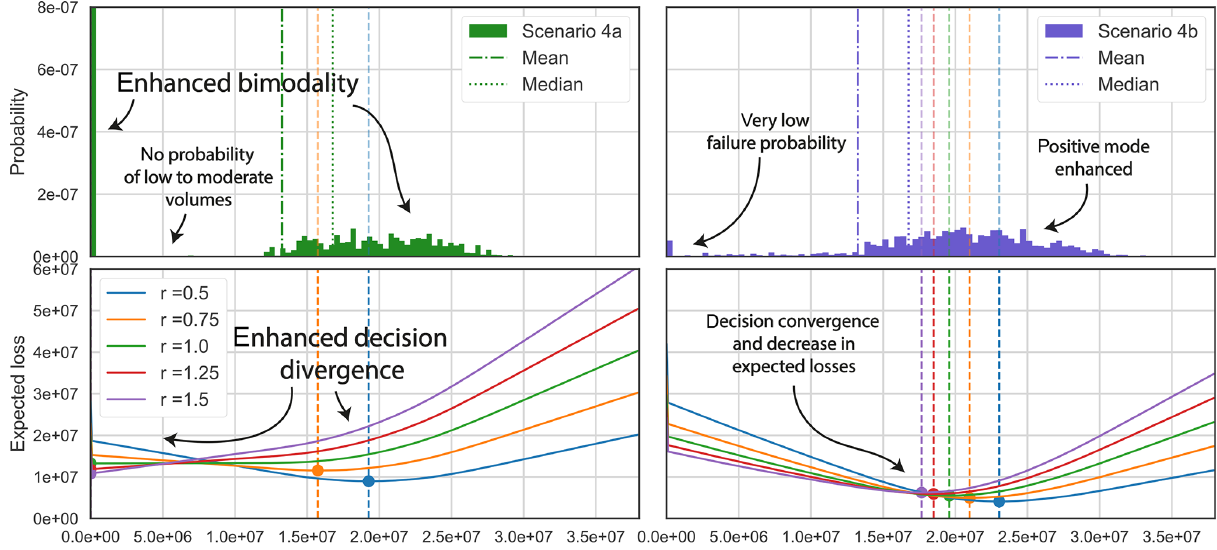
Figure 7. Trap volume distribution and resulting loss function realizations for Scenario 4a and Scenario 4b. Adding a likelihood of the SSF being around its critical value led to increased bimodality and an elimination of low to moderate volume probabilities. Bayes actions diverged accordingly in Scenario 4a. Implementing a reliable SSF value likelihood ( µ = 2, σ = 0 . 3) in combination with the thick seal likelihood from Scenario 2a resulted in an emphasis on highly positive volumes. This, in turn, led to a stark convergence of decisions and reduction of expected